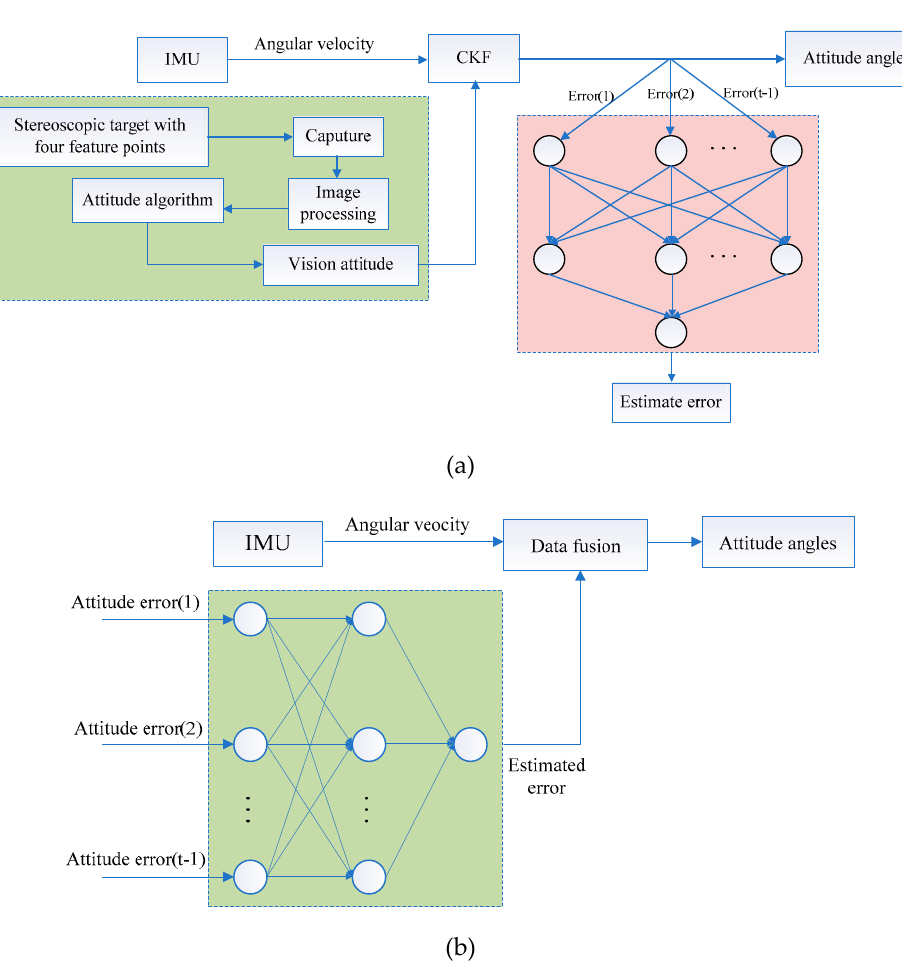
Figure 4. Processing of (a) RBF training with vision data; and (b) RBF prediction without vision data. IMU: inertial measurement unit.